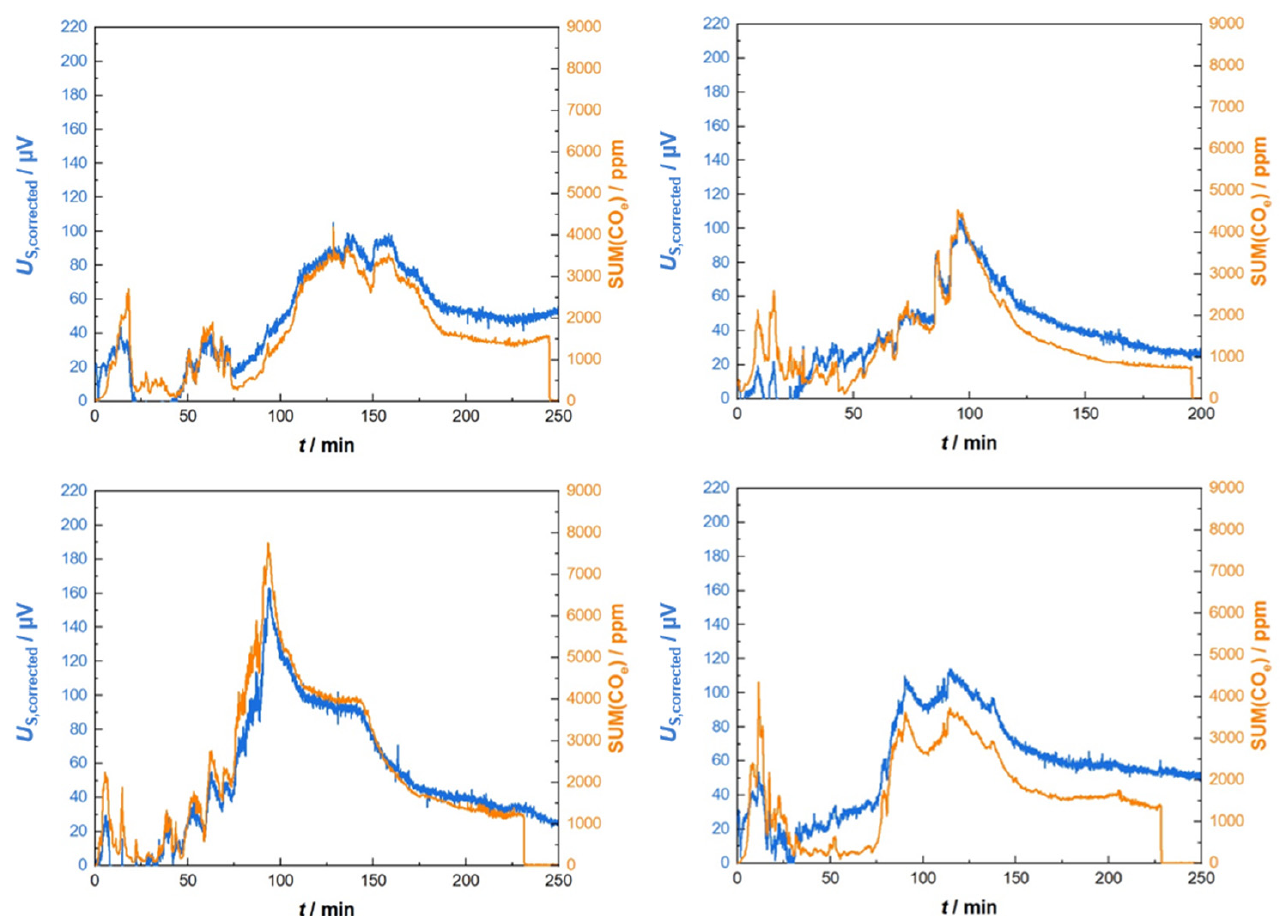
Figure 10. Sensor performance (Gen_2) during four different combustion cycles. Heating power correction and sum calculation was achieved with one parameter set such as that described in the text.